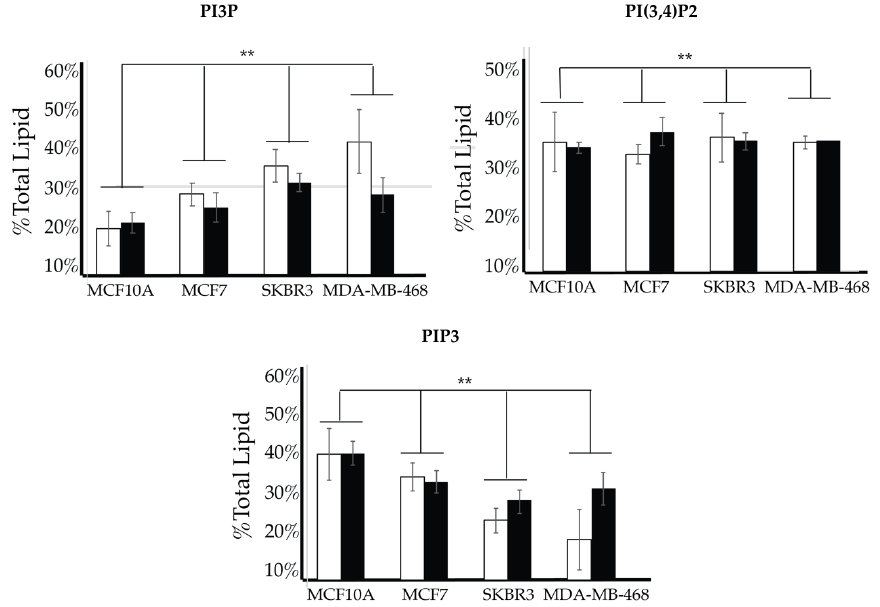
Figure 14. Comparison of cell surface lipidomes across cell types. Comparison of the PI3P, PI(3,4)P2, and PIP3 content of each of the studied cell lines where the normal ( (cid:114) ) and hyperglycemic ( (cid:121) ) serum conditions led to two-way ANOVA statistically significant di ff erences (** denotes p <